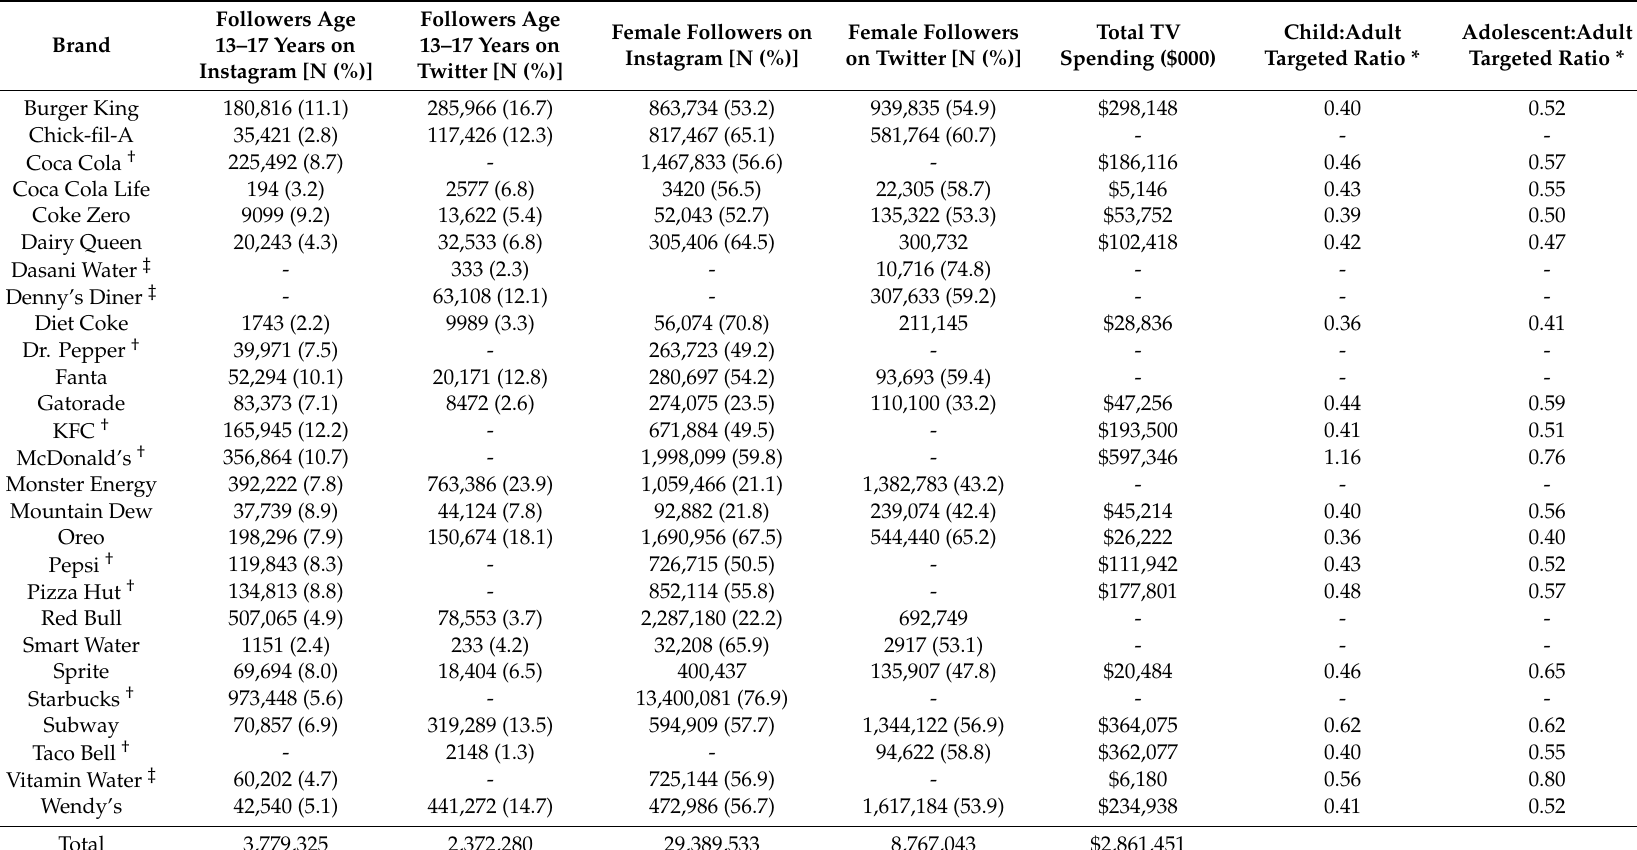
Table 2. Total TV spending and targeted marketing characteristics of popular food and beverage brands ( n = 27),